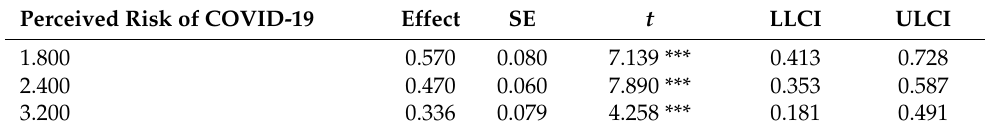
Table 7. Conditional effects of health concern at values of perceived risk of